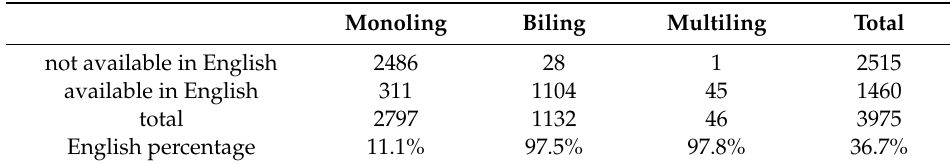
Table A46. English language availability (ro).